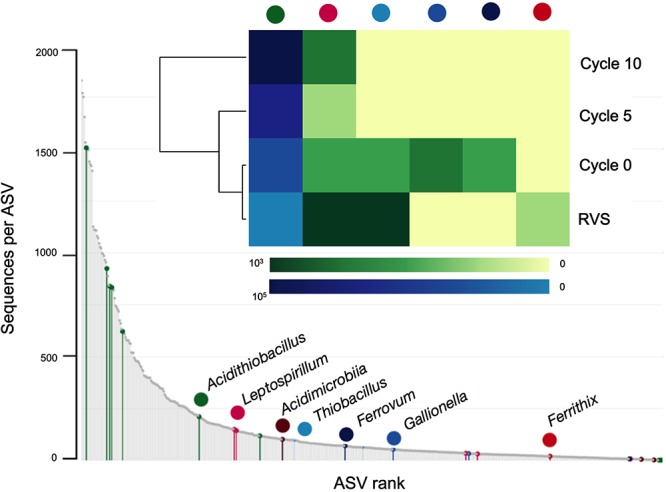
Rankabundance and heatmap of known acidophilic taxa during adaptation of the RVS microbial consortium. Values in heatmap are the actual read variant abundances of the top 2,000 ASVs.